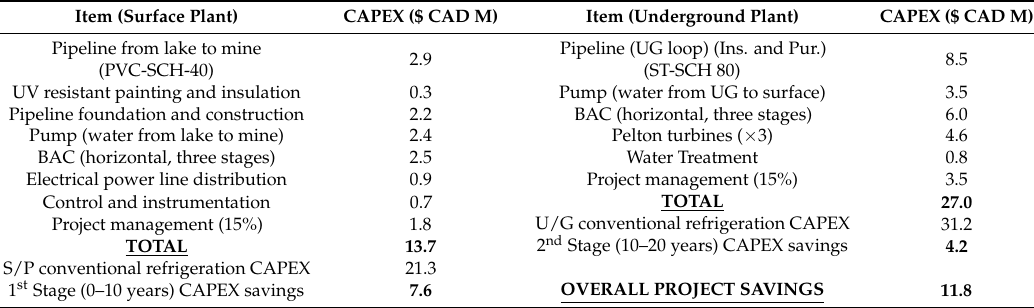
Table 7. Deep lake cooling plant cost estimation (CAPEX